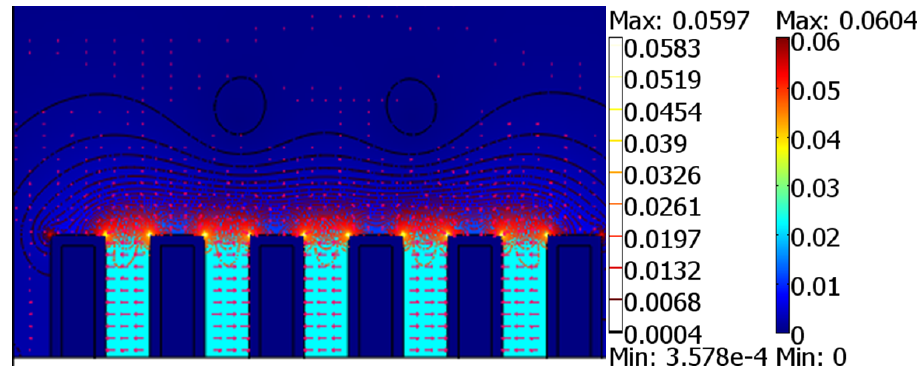
Figure 6. Electric field (surface, contour and arrow plot) profile surrounding the rectangle electrodes with constant potential of 0.585 V on cathode and − 0.32 V on anode.